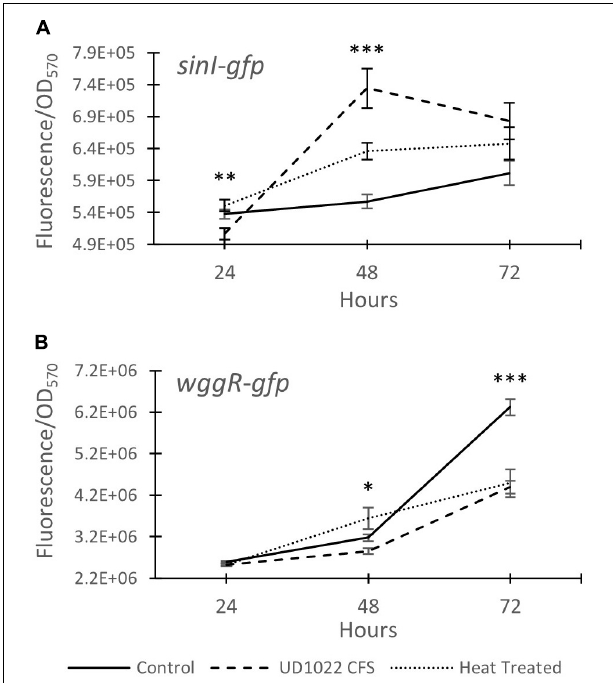
FIGURE 4 | Expression of Rm8530 quorum sensing genes. (A) Average GFP activity (fluorescence/OD 570 ) of the sinI-gfp fusion reporter. UD1022 treatment was significantly different from control and heat treatments at 24 hours. The differences between treatments at 48 hours is significant at p -value of < 0.0001. (B) Average GFP activity of wggR-gfp fusion reporter. The differences between the treatments and the control at 48 hours is significant at p -value of 0.04, and 72 hours is significant with p -value of < 0.0001. Averages for both assays are from 29 technical replicates and the bars at each time point present standard error. *indicates p < 0.05, ** p < 0.005, and *** p <